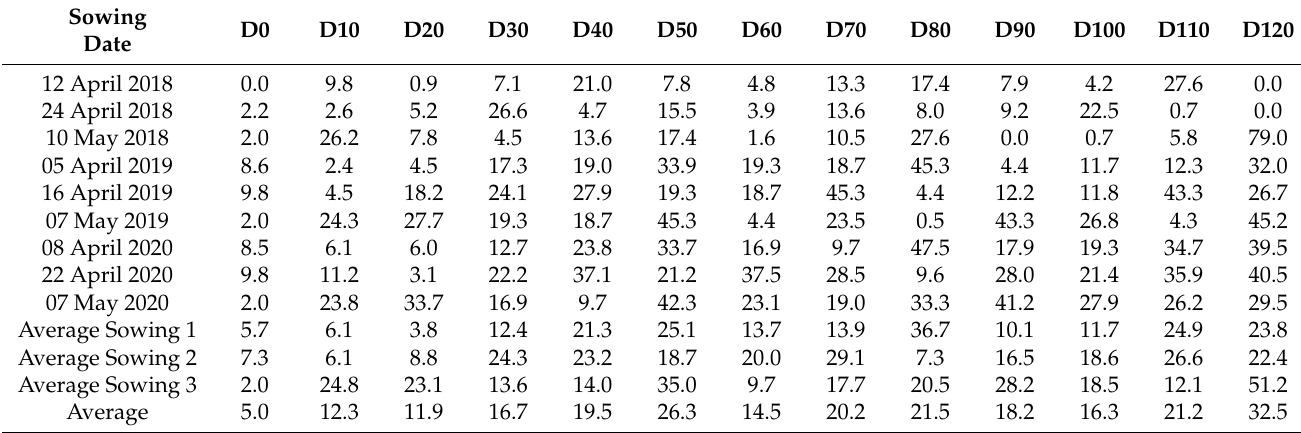
Table 6. Precipitation amounts (mm) in 10 days for individual sowing